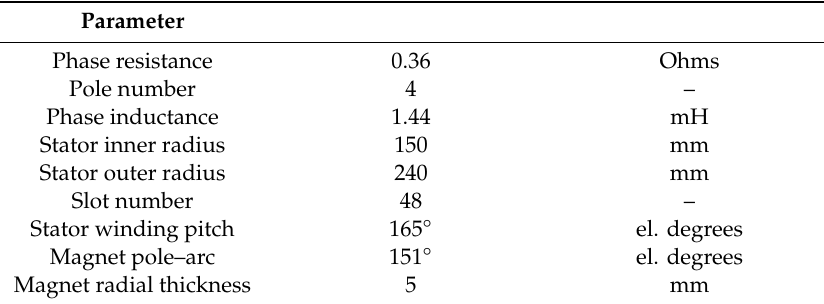
Table 1. Parameters of the 6- φ